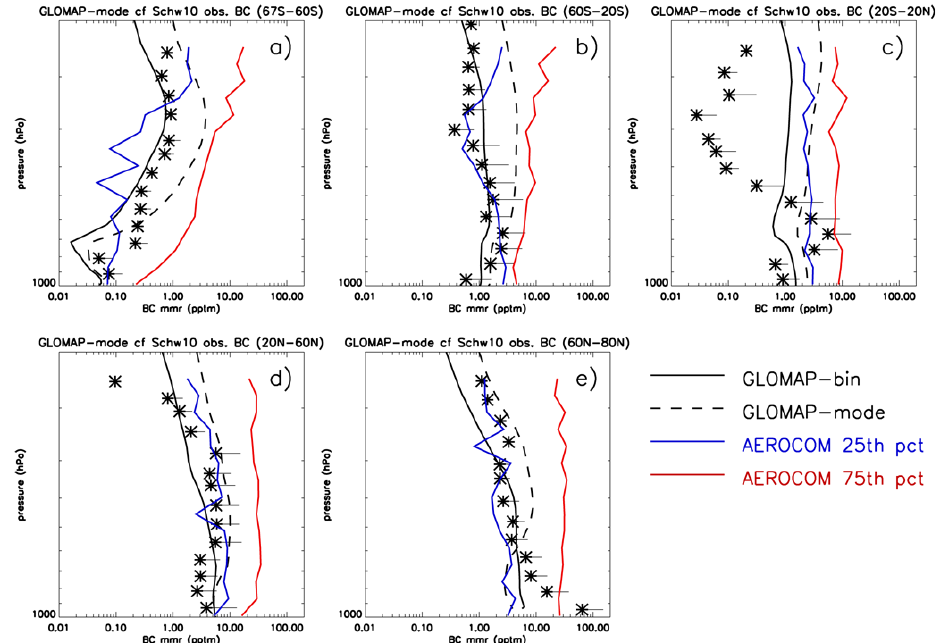
Fig. 7. Vertical profiles of simulated BC mass mixing ratio for GLOMAP-bin (solid) and GLOMAP-mode v6R (dashed) against aircraft SP2 observations (asterisks) from Schwarz et al. (2010). The whiskers on the observations show the standard deviation over the measurements in each 1-km bin. The blue and red lines show the 25th and 75th percentiles from models participating in AEROCOM phase